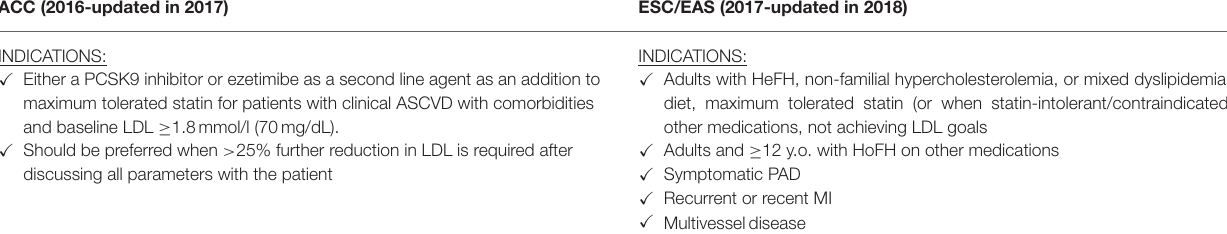
Specific criteria: Added on statin and ezetimibe: (1) Severe ASCVD and LDL > 2.6mmol/L